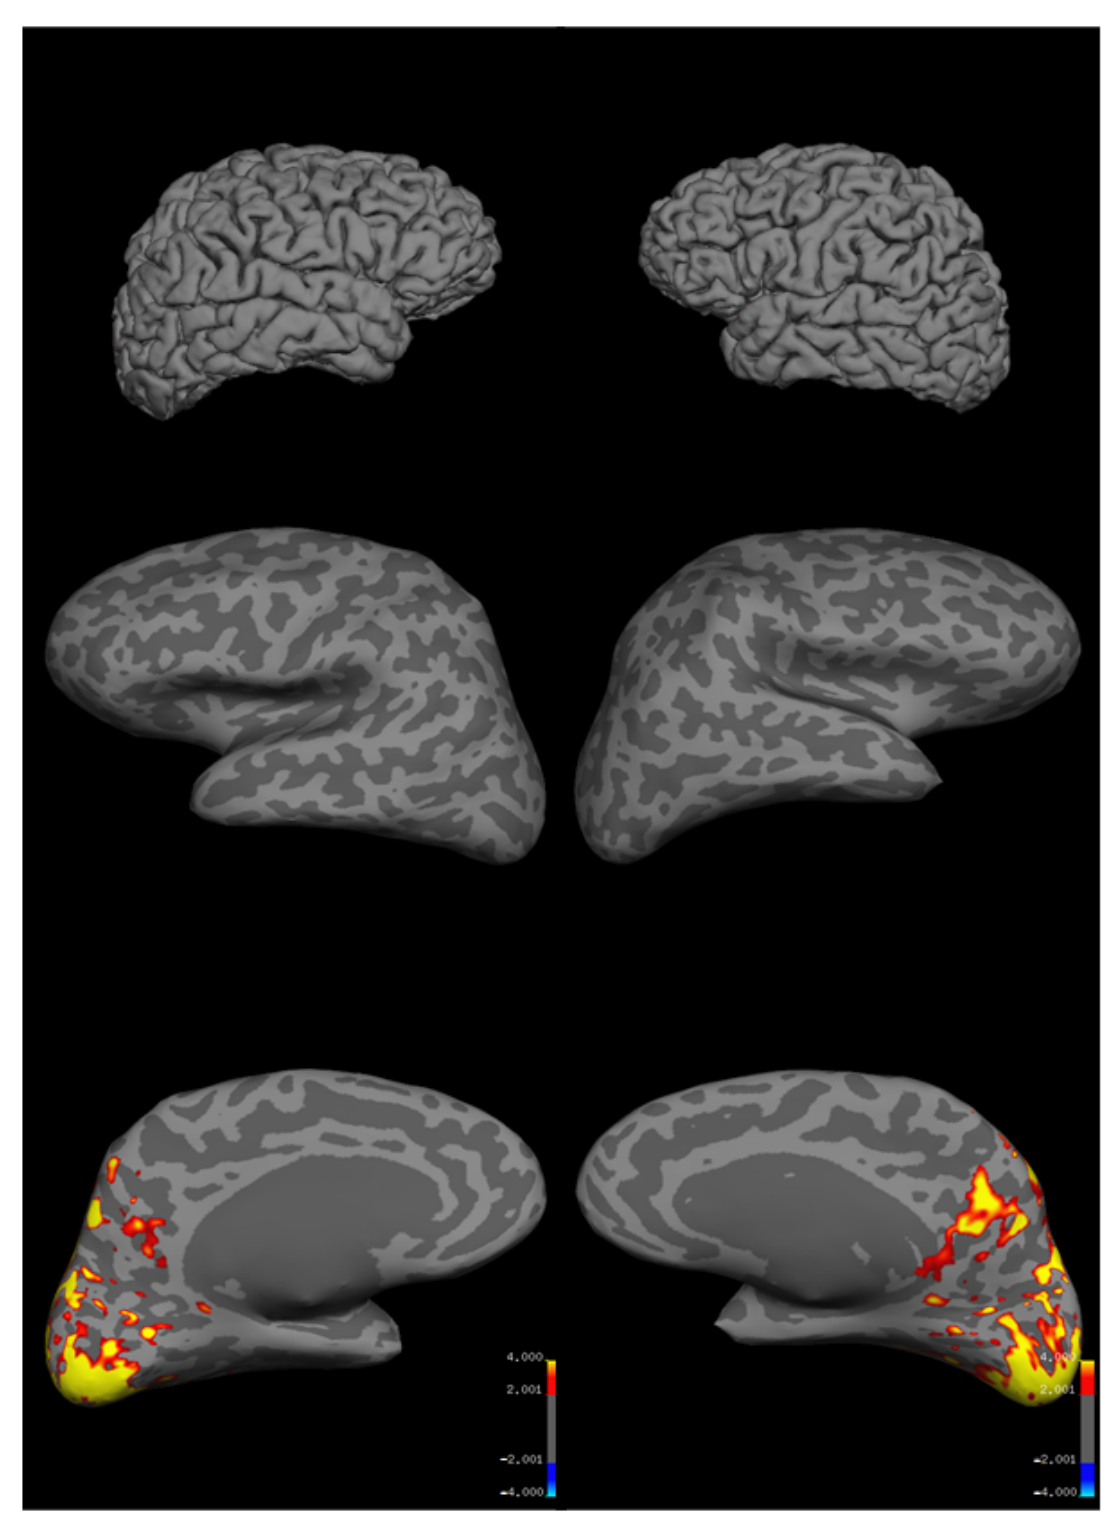
Figure 7. Three Tesla fMRI. Segmented brain from the T1 MPRAGE ( top ), inflated brain ( middle ), and functional BOLD images projected onto the inflated brain surface ( bottom ).